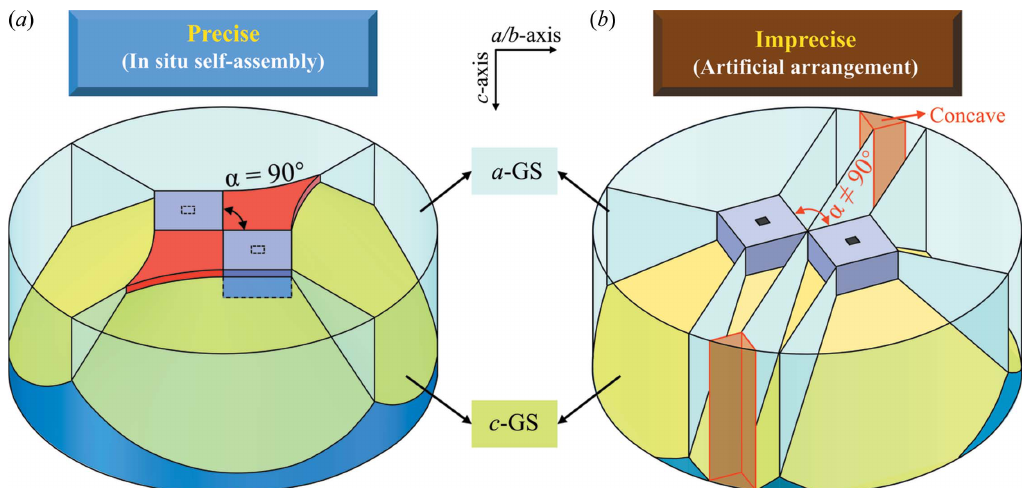
Figure 6 Perspective schematics showing the structures of crystals induced by ( a ) ISSA precise (110)/(110)-aligned seeding and ( b ) artificially arranged imprecise (110)/(110)-aligned seeding. Angle (cid:3) indicates the in-plane angle between two (100)-sided grains (coloured